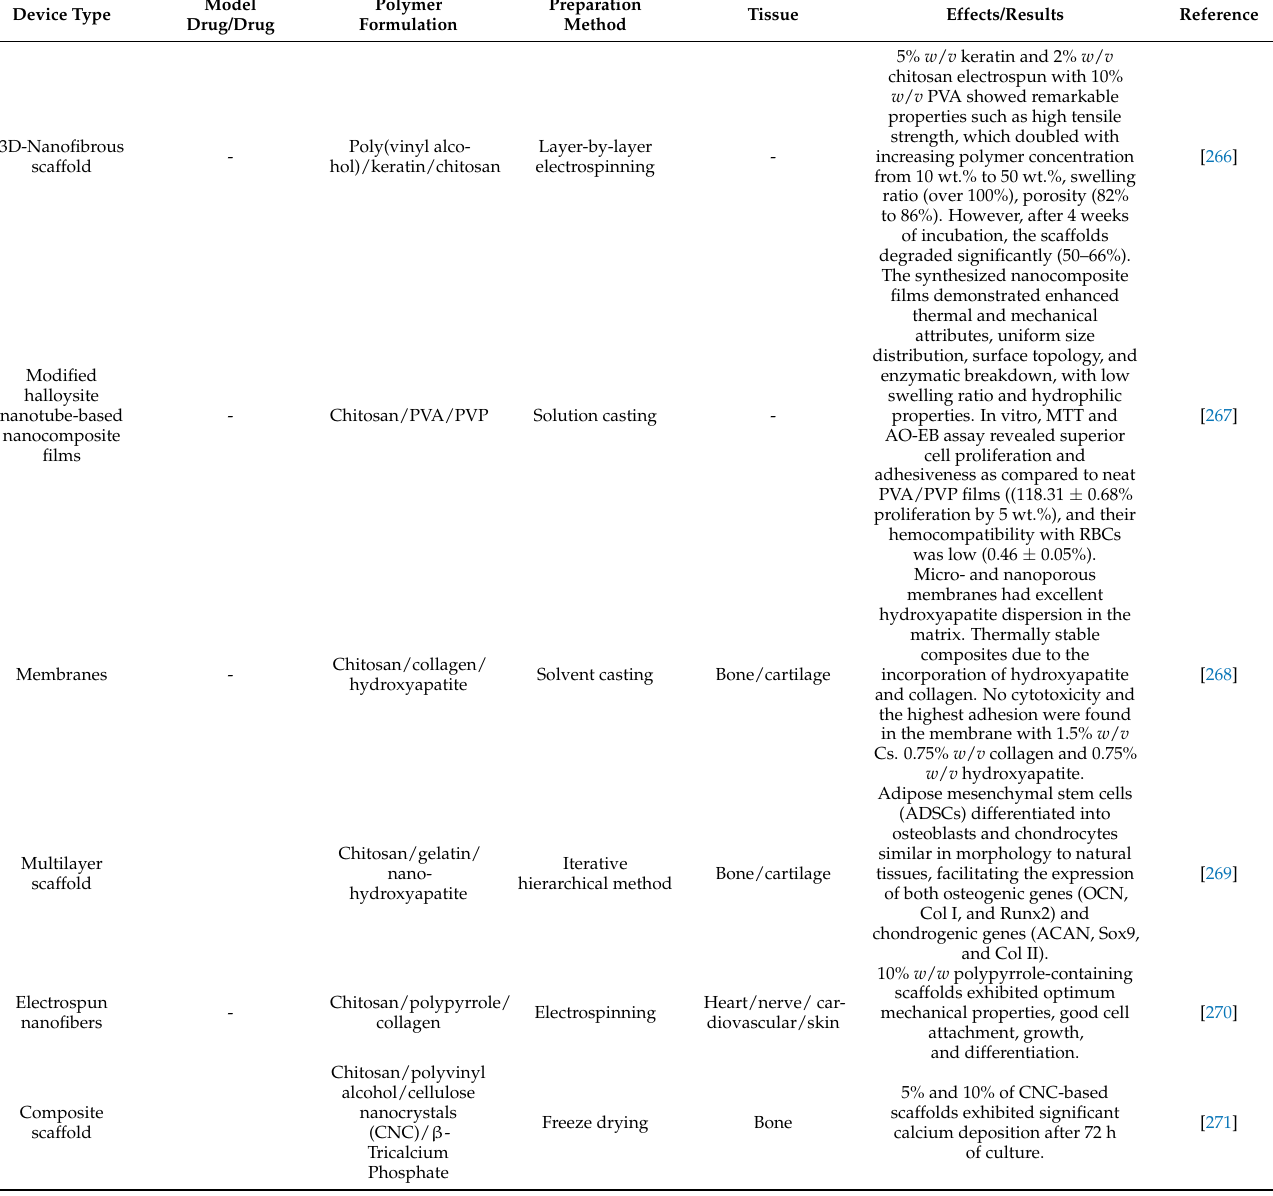
Table 2. Recent studies focusing on tissue engineering applications of chitosan